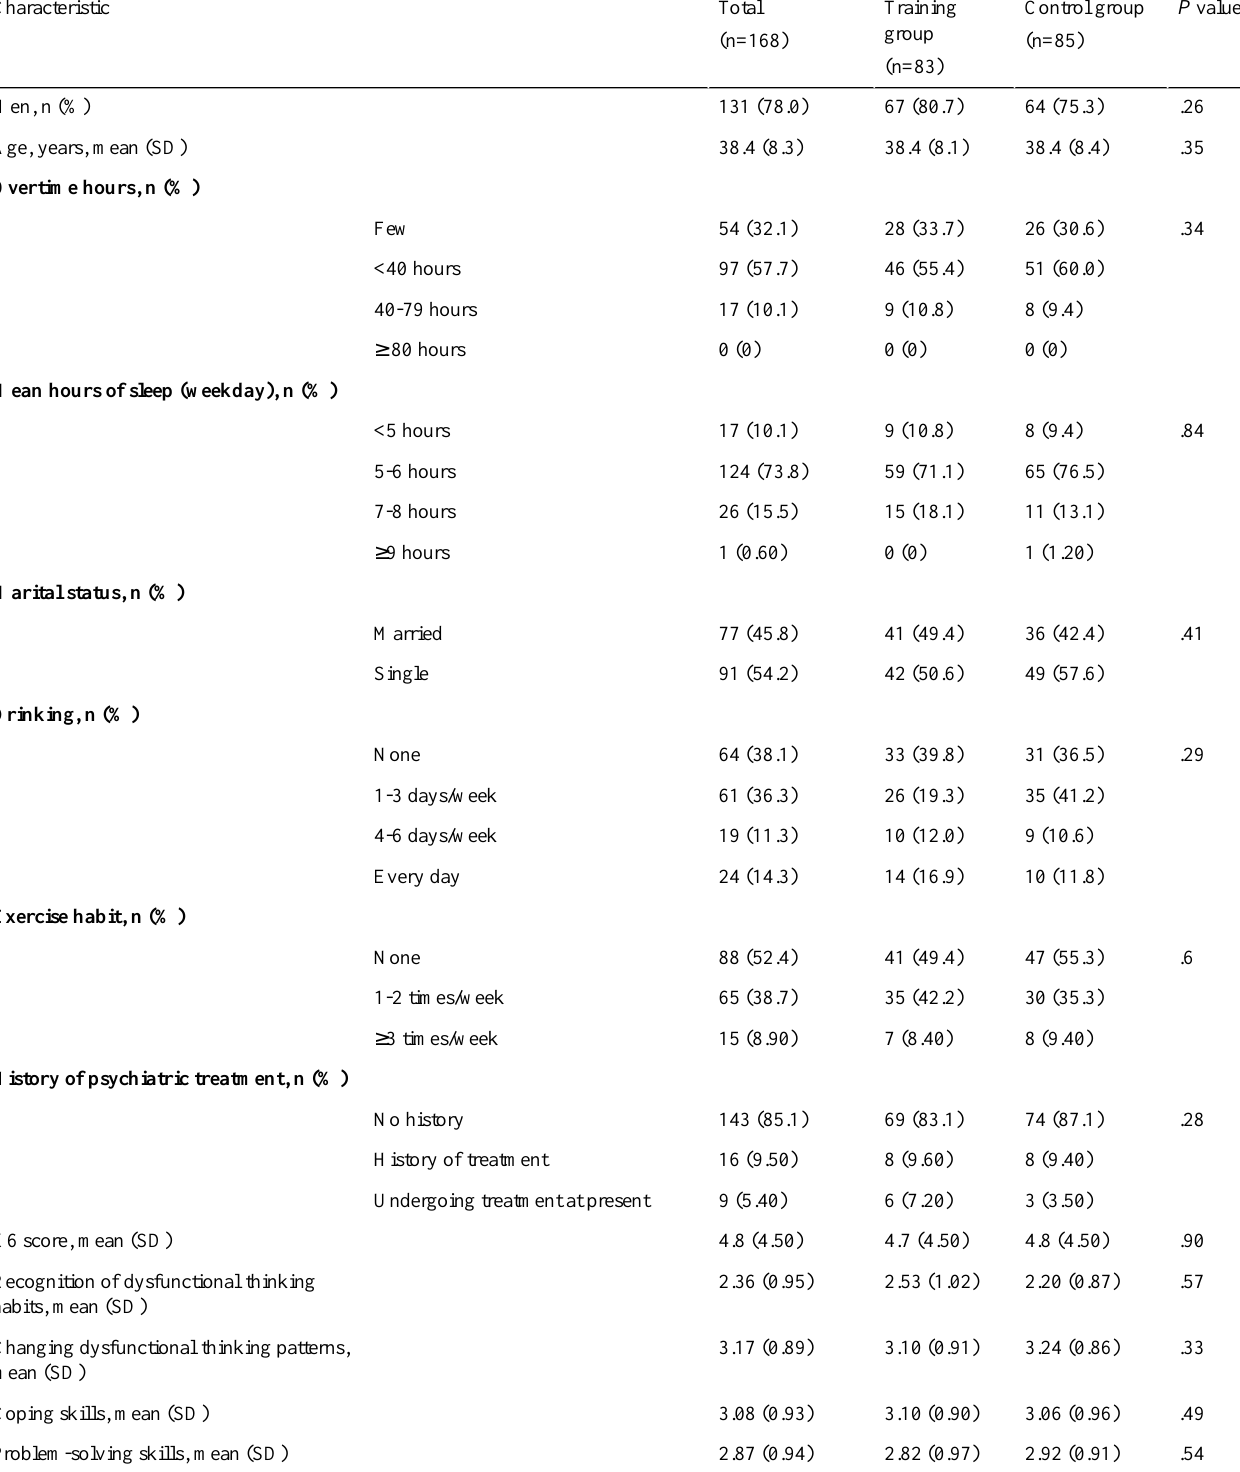
Table 1. Baseline characteristics of participants in training and control groups.